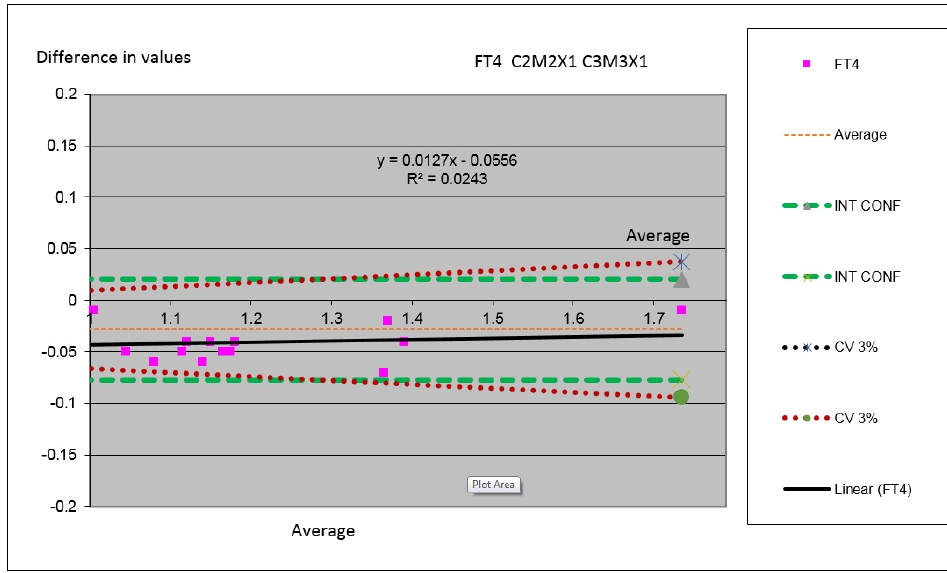
Figure 11. Comparison between modules for the parameter Free T4 in which we have compared the results obtained by the measurements performed in the two machines (Analyzer C3 substituted by C2 in which the Module 2 is substituted by the Module M3 and the Channel X1 is substituted by the Channel